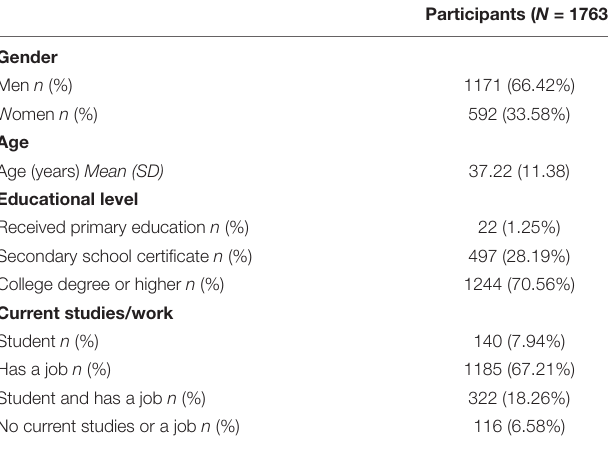
TABLE 1 | Demographic characteristics of the sample ( N =